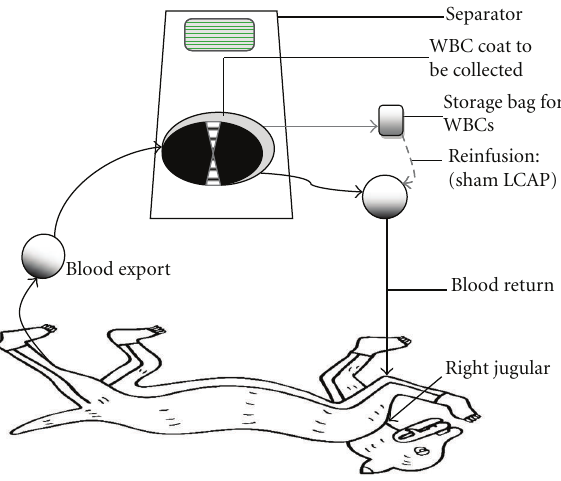
Figure 1: Schematic summary of LCAP and sham-LCAP proce- dures. LCAP was performed by an automated continuous-flow blood cell separator. The parameters were set based on the targets. The total separated cycles were adjusted according to the e ffi ciency of separation during the LCAP process. The sham-LCAP group underwent all the same procedures as the LCAP group except for removal of the leucocytes, carried out by continuous reinfusion of the separated leucocytes in the storage